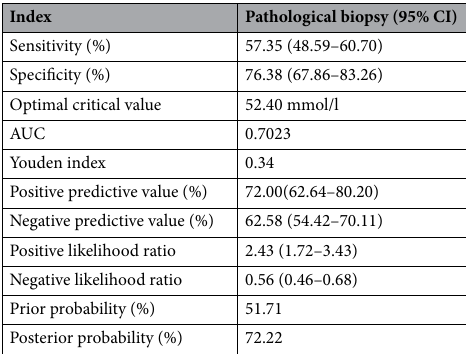
Table 3. The performance indices of the HE4-based diagnostic test. AUC area under the curve.